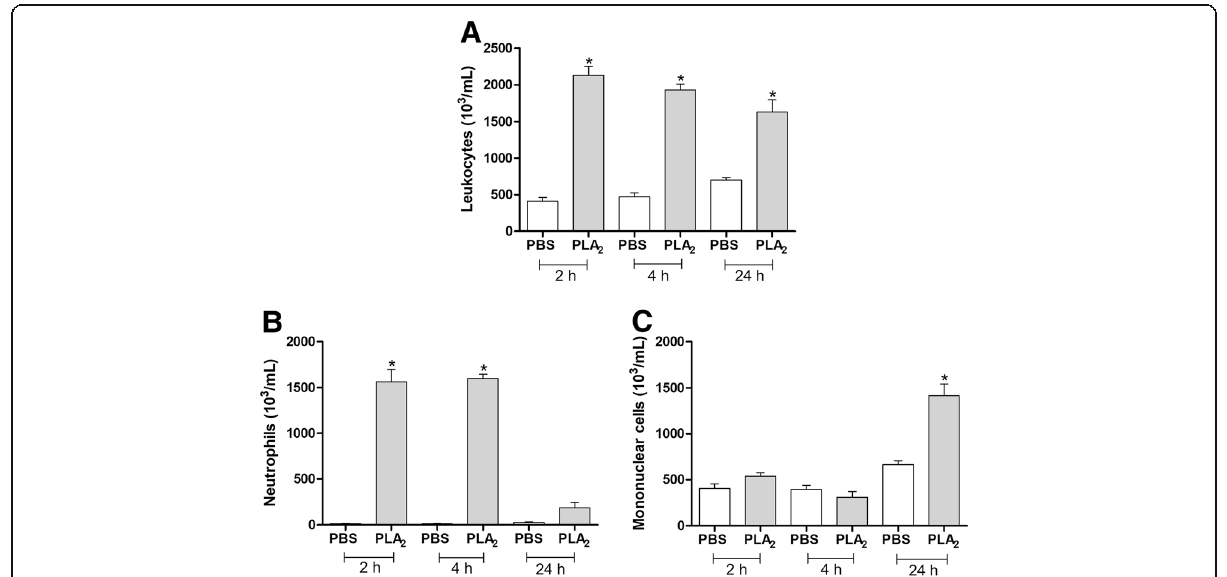
Fig. 8 Leukocyte recruitment induced by BJ-PLA 2 -I in mice after different stimulation periods. Migrations of total leukocytes ( a ), neutrophils ( b ) and mononuclear cells ( c ) were evaluated at 2, 4 and 24 h after the injection of BJ-PLA 2 -I (10 μ g/mL) in the peritoneal cavity of mice. Control groups were injected only with PBS. Results were expressed as means ± SD ( n =5) of two independent experiments. * p <0.05 compared to the control group (PBS)